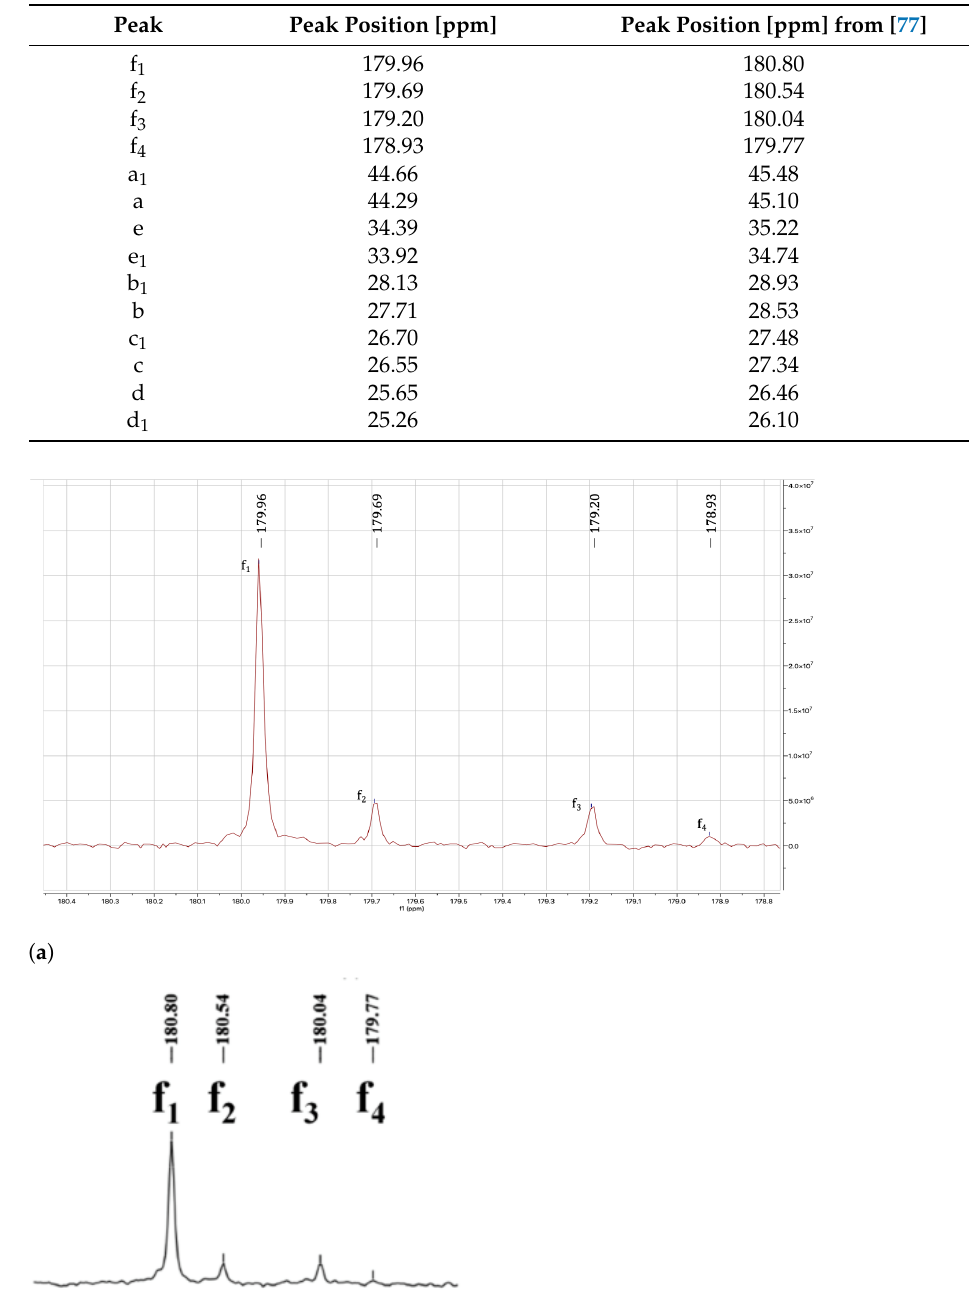
Table A1. A comparison between the peak positions of the characteristic peaks for PA 6/66 random copolymers from the 13 C-NMR spectrum of the employed HMWPA copolymer and the spectrum obtained by Tang et al. (2018) for a PA 6/66 random copolymer with a molar fraction of 15% PA 66 [77].